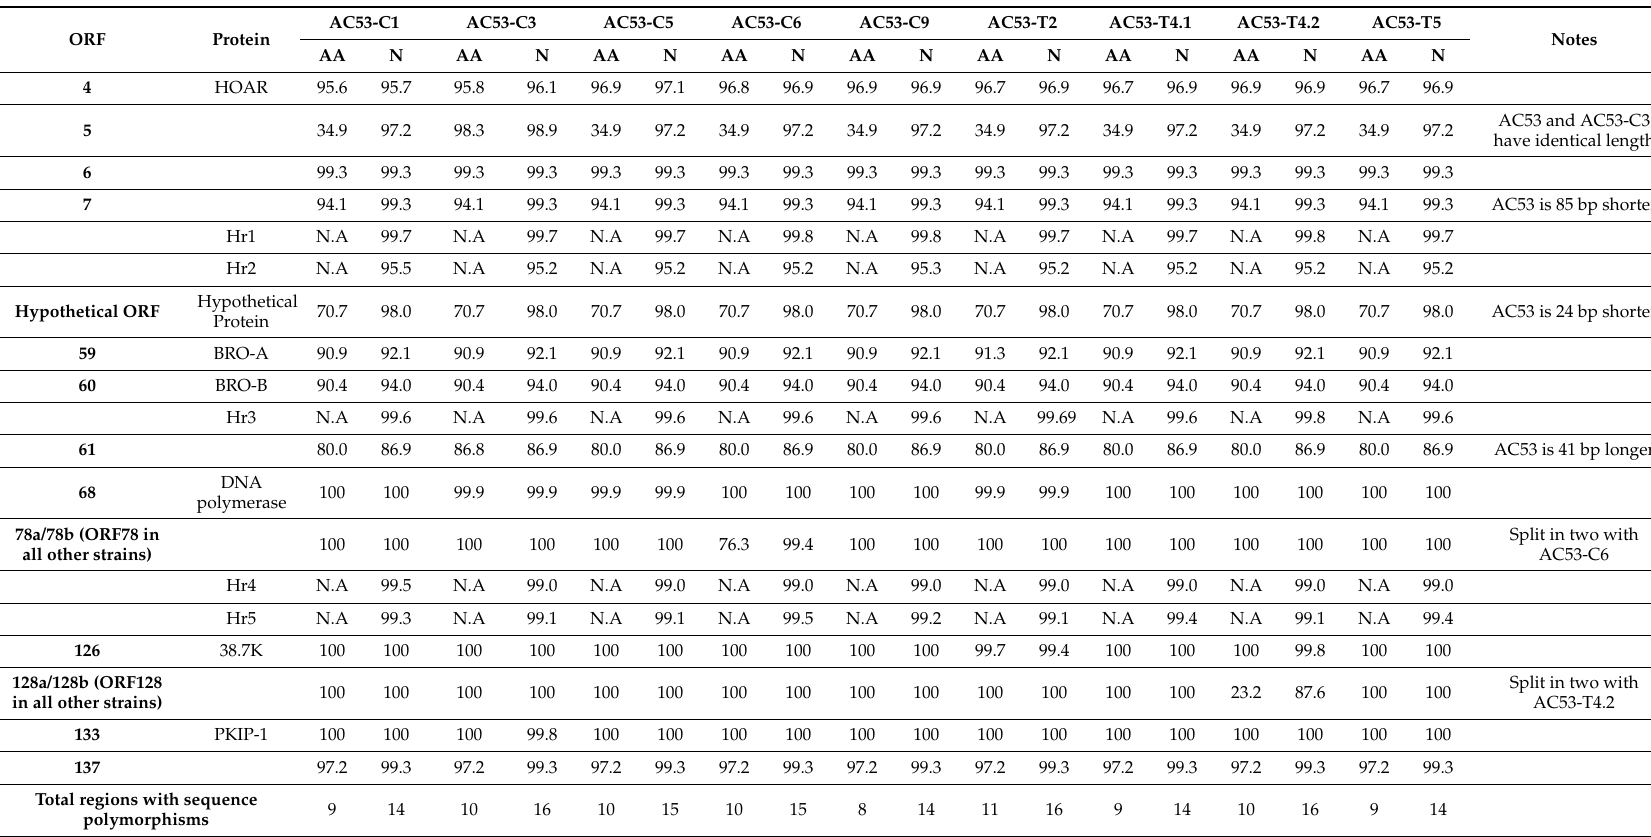
Table 3. Amino acid (AA) and nucleotide (N) identity (%) of the regions that are not identical to AC53. The main difference between AC53 and the derived strains occur with both baculovirus repeated open reading frame (BRO)-A and BRO-B, Hr1–Hr5 and HOAR, which is to be expected due to the known hypervariability of the regions. However, open reading frame (ORF) 7 and the hypothetical ORF contains an early stop resulting in a smaller sequence, whereas ORF61 is longer due to the derived strains containing an early